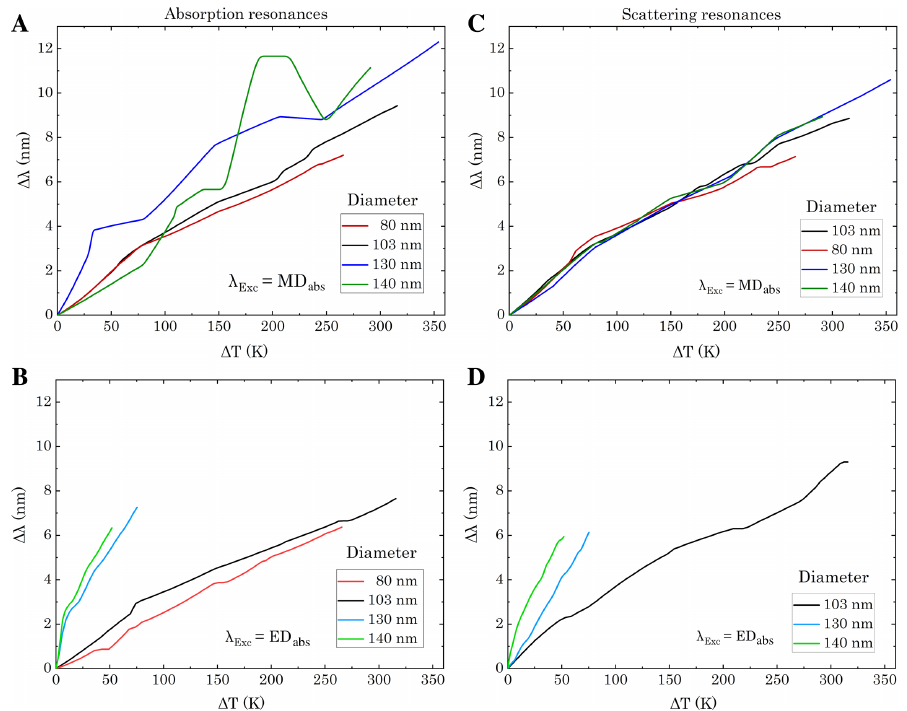
Figure 4: Self-Induced thermo-optical shifts of the magnetic dipole (MD) and the electric dipole (ED) resonances of silicon nanospheres of increasing